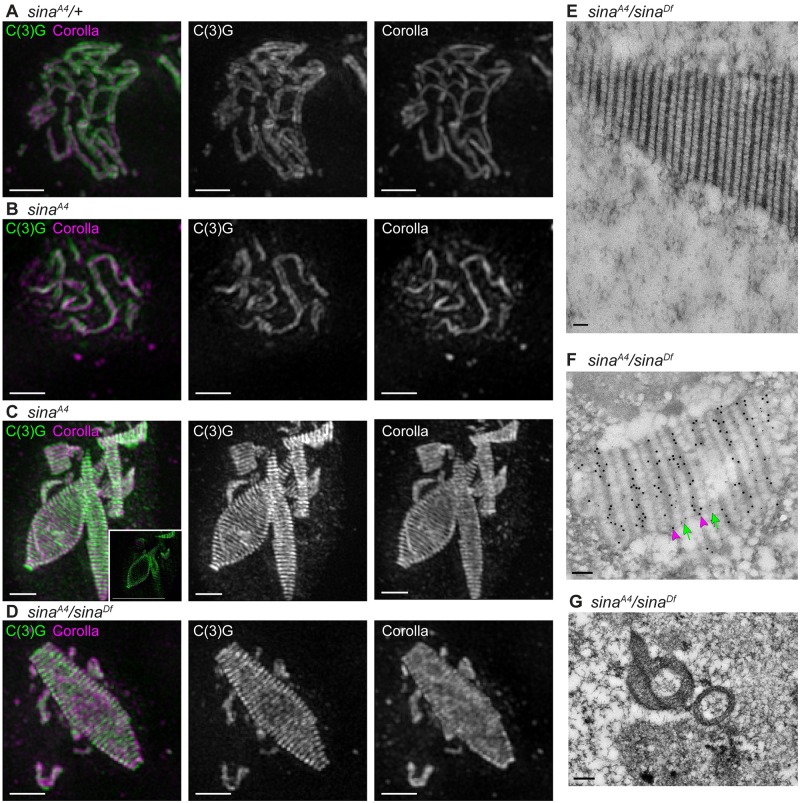
SIM and immuno-EM reveal a structure comprised of a repeating pattern of central region proteins.(A-D) SIM using an antibody recognizing the C-terminus of C(3)G (green), which localizes at the lateral element and is resolved as two tracks in wild type [8], and the central element component Corolla (magenta). Scale bars, 1 μm. Images are projections of nuclei from a larger z-stack. (A) sinaA4/+ nucleus with wild-type tripartite SC. (B-C) sinaA4 nuclei showing (B) a small region of SC in early pachytene with tripartite structure and (C) polycomplexes from a mid-prophase oocyte. Inset in (C) shows a single z-slice, illustrating that the central region components appear to be absent from the center of the large polycomplex. (D) sinaA4/sinaDf nucleus with a large polycomplex. (E) EM image of a sinaA4/sinaDf polycomplex, illustrating its repeating structure. Scale bars, 100 nm for (E-F). (F) Immuno-EM with the C-terminus of C(3)G labeled with small gold particles (green arrows) and Corolla labeled with larger gold particles (magenta arrowheads) on a polycomplex from a sinaA4/sinaDf ovary. The C-terminus of C(3)G localizes to bands having similarities to wild-type lateral element lines in EM and alternates with Corolla, which localizes to bands having similarities to central element lines in wild type. (G) EM section through two polycomplexes in sinaA4/sinaDf ovaries. The section is interpreted to be an oblique section through the polycomplex on the left based on a similar-looking EM section of a polycomplex described in [45]. The section illustrates the polycomplexes have a hollow inside appearance. Scale bar, 0.2 μm.